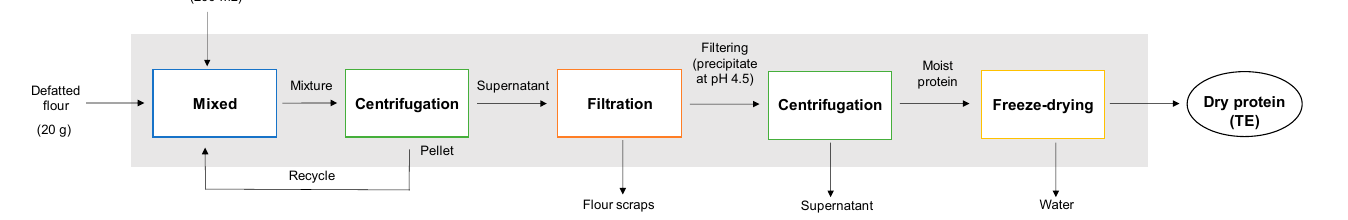
Figure 1. Flow chart describing the total extraction method of chickpea protein.